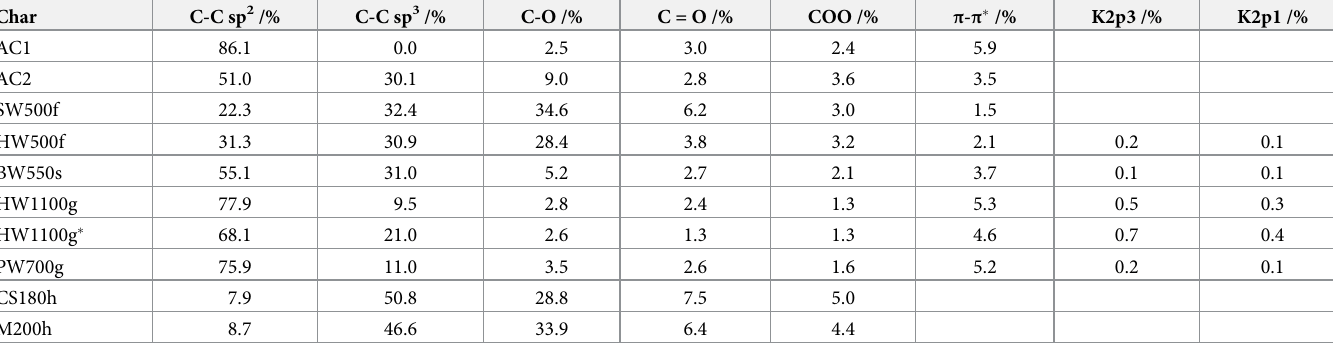
Table 7. XPS of C1s at the surface of ground chars and sample HW1100g � without pretreatment. Char C-C sp 2 /% C-C sp 3 /%